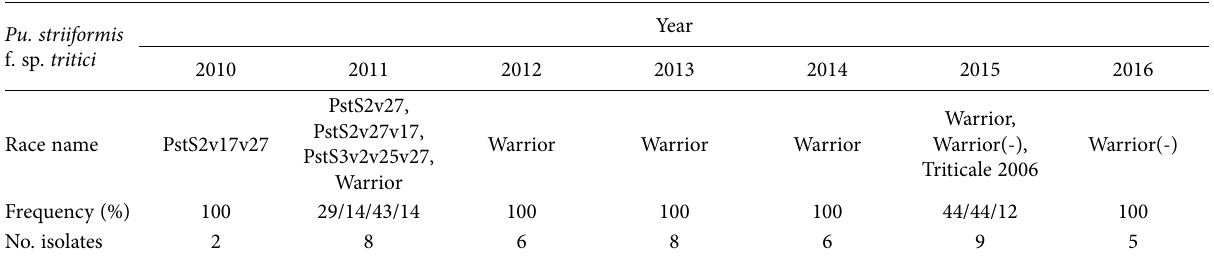
Table 2. Races of Puccinia striiformis f. sp. tritici (yellow or stripe rust) in Spain during 2010–2016, according to the Global Rust Reference